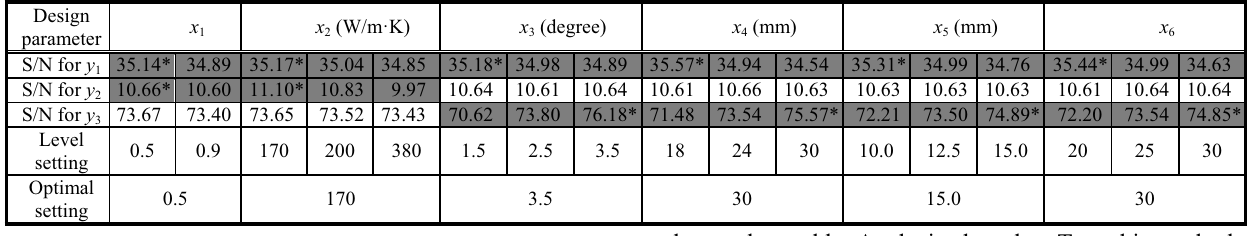
Table 12. Analytical results from the Taguchi